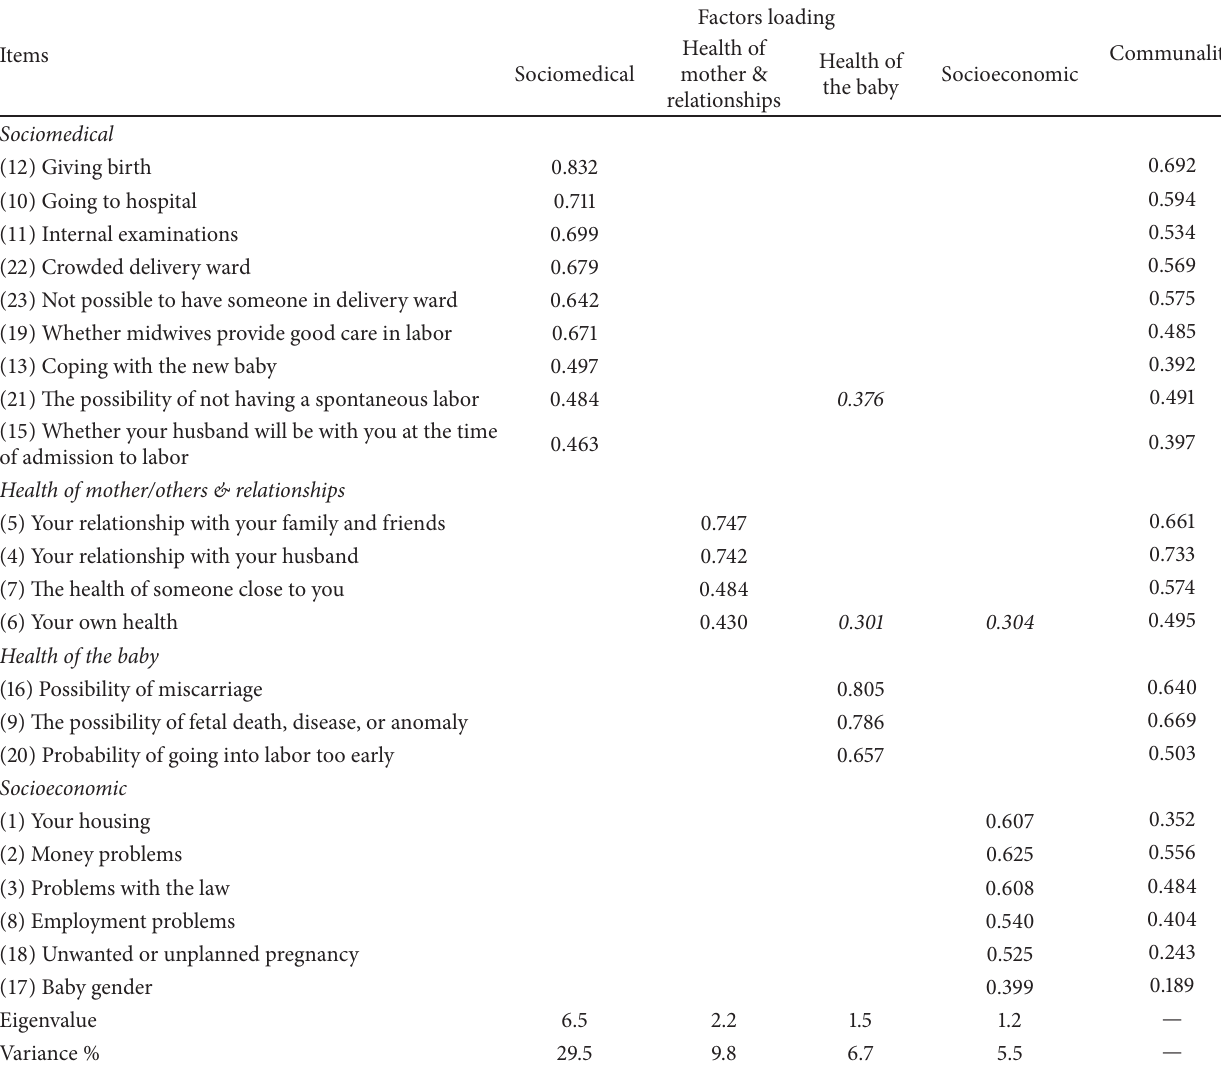
Table 3: The Farsi Cambridge Worry Scale four factors and factor loadings (22-item version).